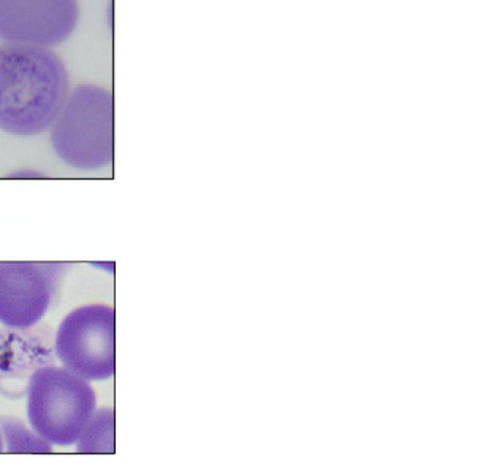
Fig 4. Erythrocytes with signs of infection by possible Hepatocystis hemoparasites observed in a single individual captured at Redcliffe in December 2018. Images taken at 1000x